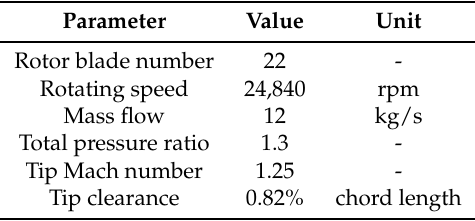
Table 1. Design parameters of the compressor.